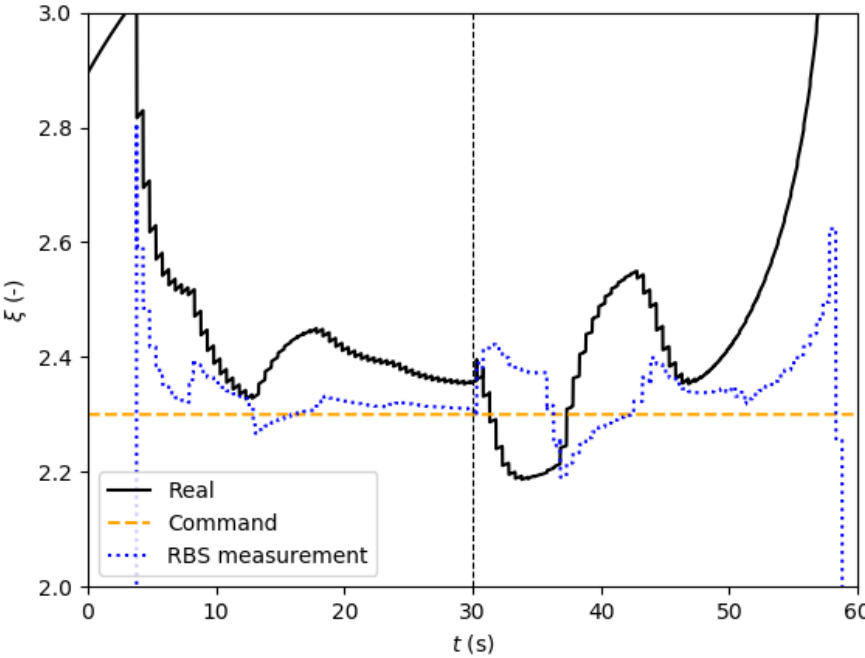
Figure 35. Mixture ratio profile, feedback with complete regulation law, case 2, ds = 3 mm.